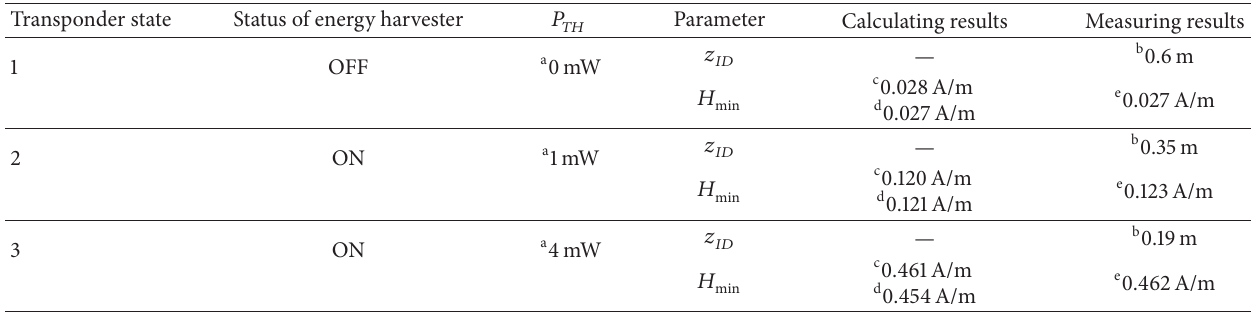
Table 3: Calculated and measured parameters of the developed